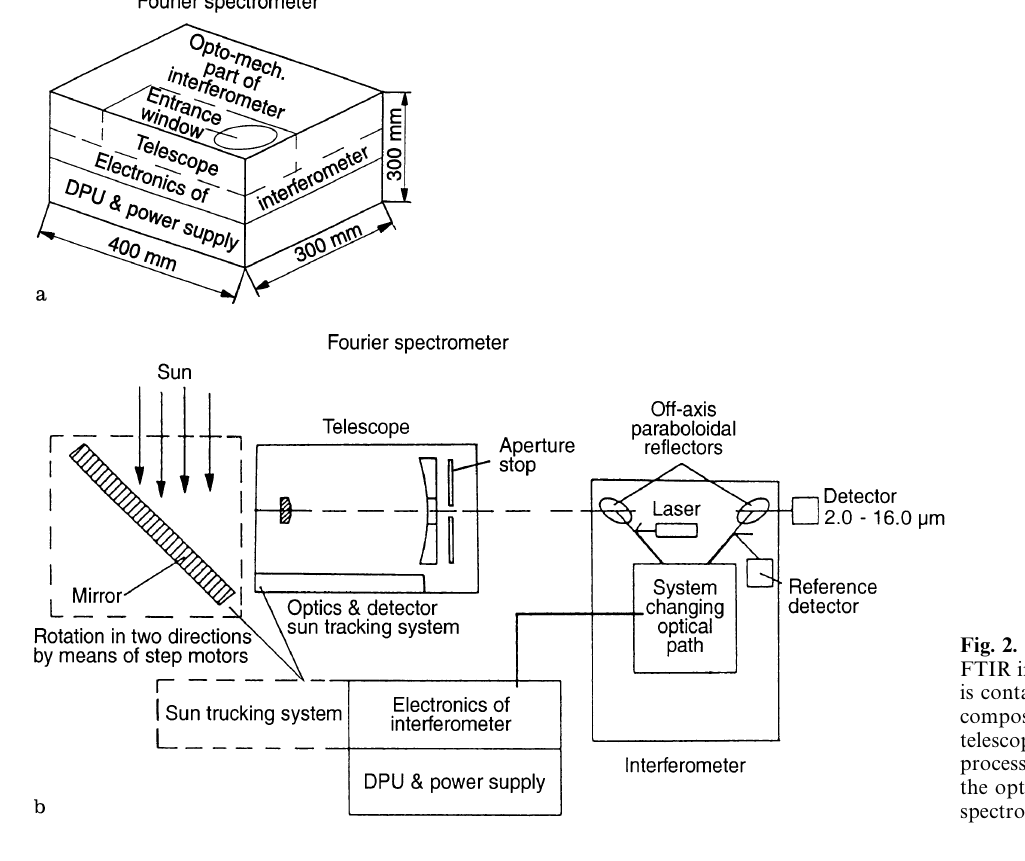
Fig. 2. a General layout of the FTIR instrument. The spectrometer is contained in one box that is composed of three main items: telescope, interferometer, data processing unit. b Block diagram of the optical part of the FTIR spectrometer (B (cid:248) e 1 cka et al .,